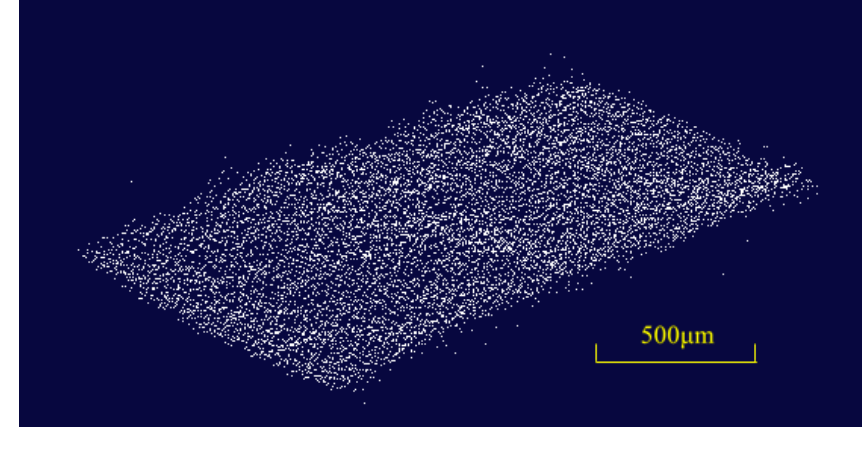
Figure 4. Point clouds after processing.